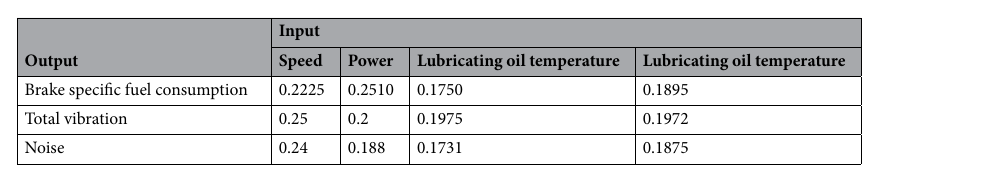
Table 7. Value of |MIV| for input